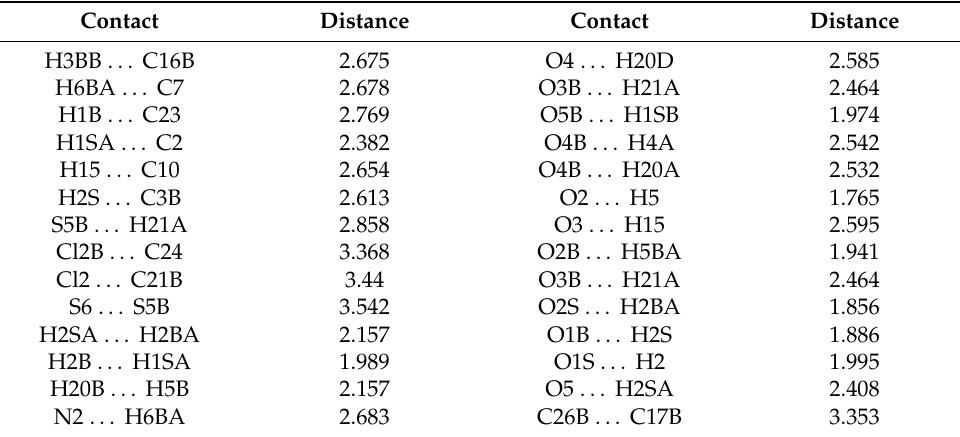
Table 4. Important contacts and their interaction distances.